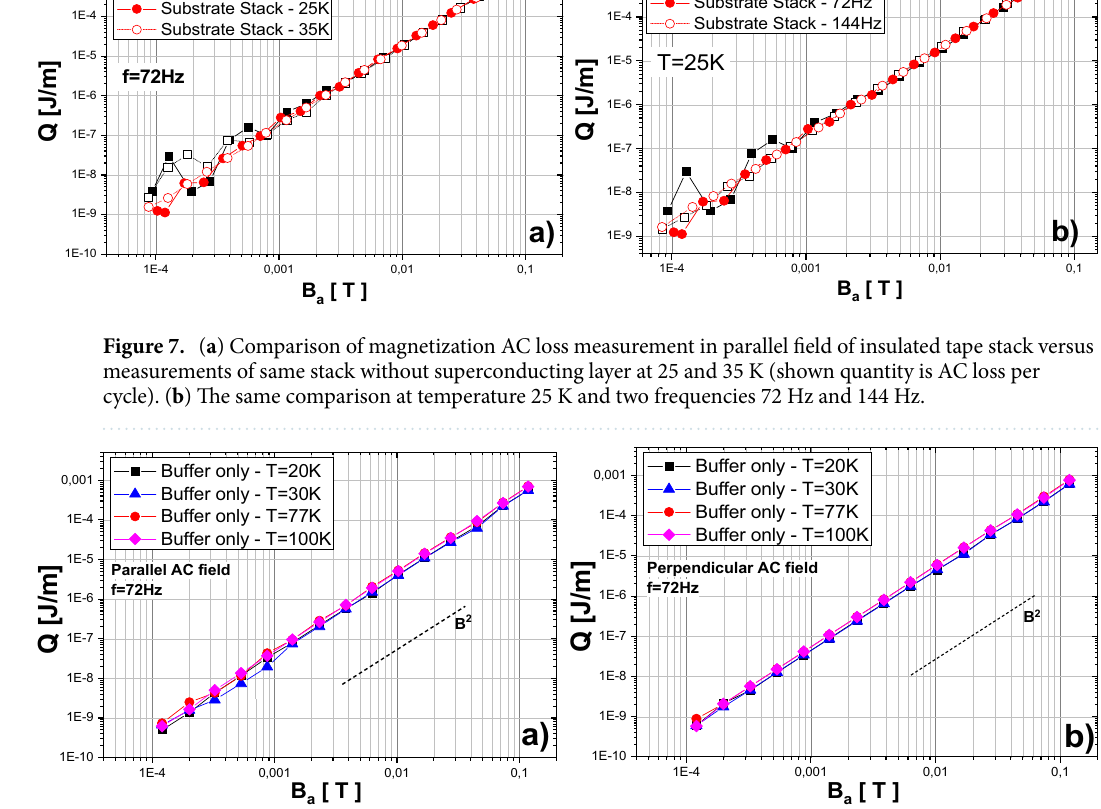
Figure 8. Comparison of measured magnetization AC loss per cycle under perpendicular and parallel field of tape stack without superconducting layer at temperatures up to 100